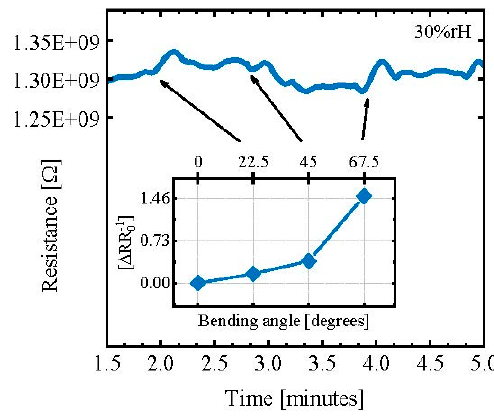
Figure 4. Resistance response under different bending angles. Inset plot presents percentage of resistance